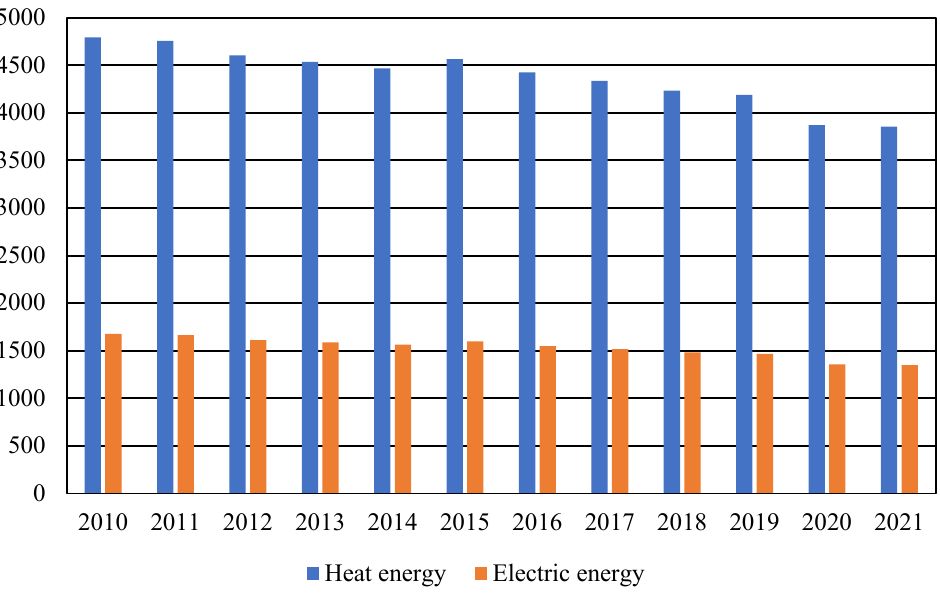
Figure 11. The thermal and electric energy equivalents of livestock by-product potential in Lithuania (thous. GJ).